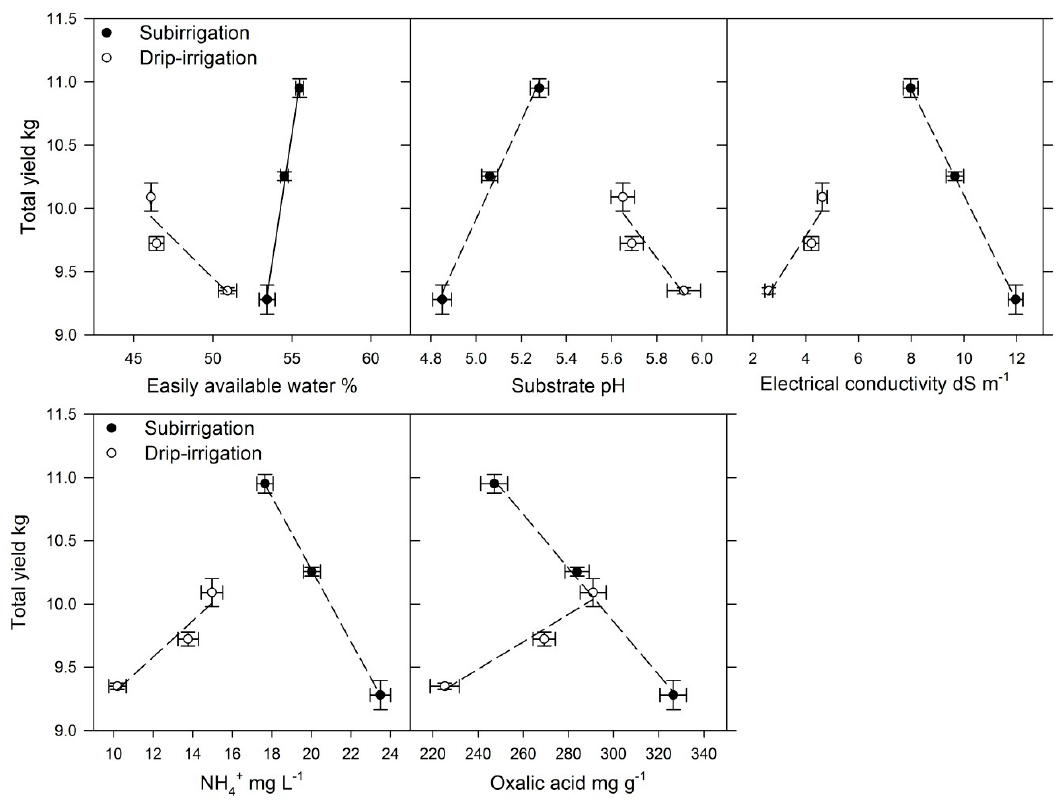
Figure 6. Relationship between some substrate physical or chemical properties as affected by irrigation method and fruit yield Solanum lycopersicum L. (tomato) plants. Each point represents the average for each nutrient solution concentration. Except for easily available water, means for substrate chemical properties were averaged across the three substrate layers. Bars represent the standard error of the mean (n = 4).